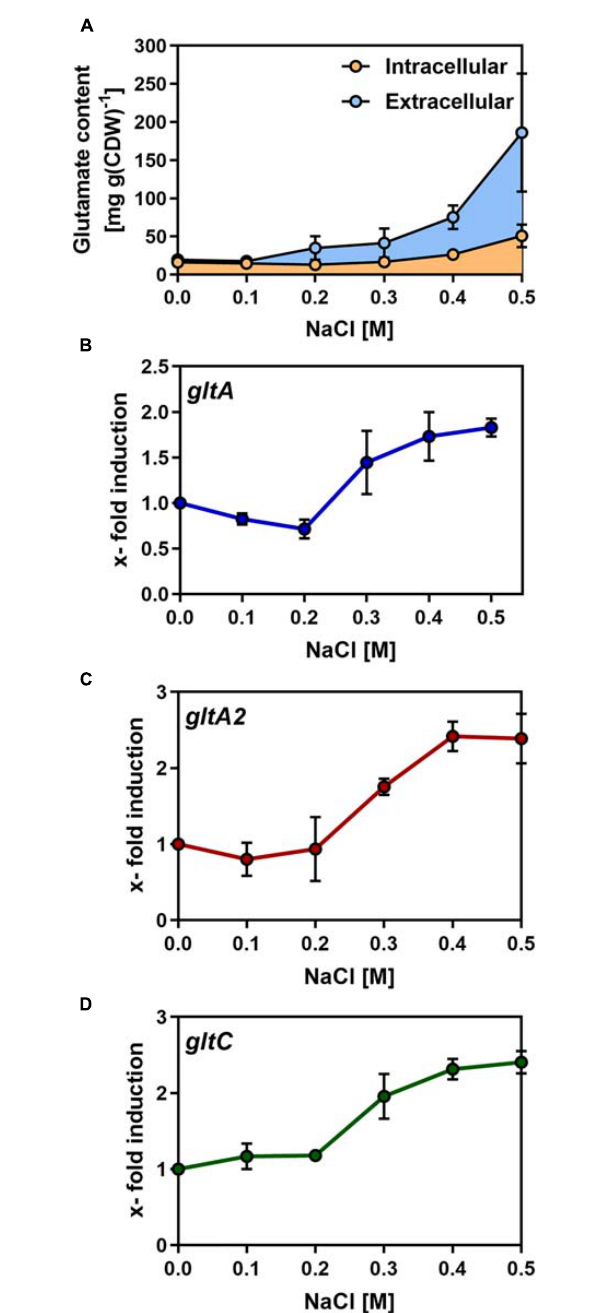
FIGURE 3 | Synthesis of L-glutamate by Bacillus methanolicus MGA3 by osmotically stressed B. methanolicus cells. (A) Cultures of B. methanolicus MGA3 were grown at 50 ◦ C in MVcM containing the indicated NaCl concentration to an OD 578 of approximately 1. Intracellular and extracellular L-glutamate was quantified by HPLC analysis. The shown data represent experiments from three biological replicates. (B,C) qPCR analysis of L-glutamate synthase encoding genes ( gltA and gltA2 ) and of the gltC regulatory gene of B. methanolicus MGA3. qPCR data for (B) gltA , (C) gltA2 , and (D) gltC were derived from cultures of B. methanolicus MGA3 grown at 50 ◦ C in MVcM containing the indicated concentrations of NaCl. The